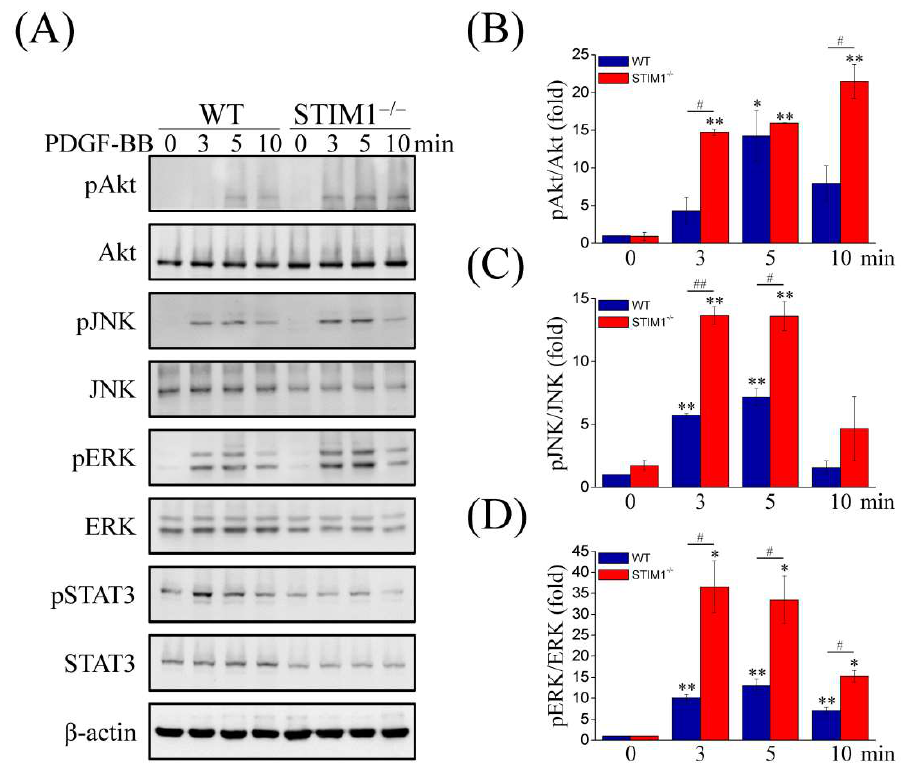
Figure 4. STIM1 knockout increases phosphorylation of Akt, JNK, and ERK but not STAT3 under PDGF-BB stimulation. ( A ) MEF-WT and MEF-STIM1 −/− cells were starved in a serum-free medium for 12 h and then stimulated with 100 ng/mL PDGF-BB for 3, 5, and 10 min. Immunoblotting analysis using antibodies against phospho-Akt (pAkt), Akt, phospho-JNK (pJNK), JNK, phospho-ERK (pERK), ERK, phospho-STAT3 (pSTAT3), and STAT3. β-actin served as the internal control; ( B – D ) Measurement of the relative intensities of protein phosphorylation are represented as mean ± SEM from three independent experiments for both MEF-WT and MEF-STIM1 −/− cells. Bar charts show the phosphorylation levels of ( B ) pAkt, ( C ) pJNK, and ( D ) pERK, which were normalized to the total protein. *,#: p < 0.05; **,##: p < 0.01 by Student’s t -test.